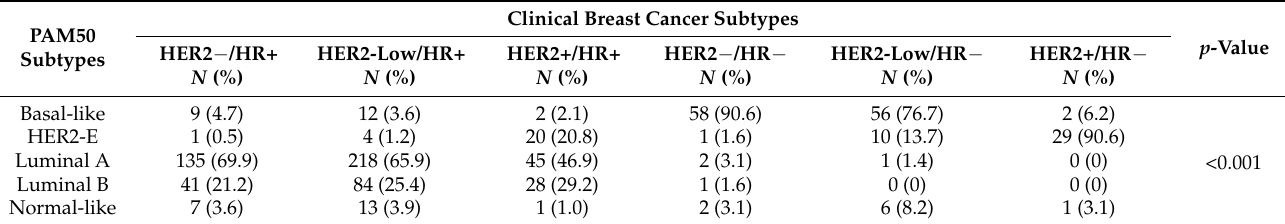
Figure 1. The distribution of PAM50 intrinsic subtypes in the entire cohort and among each breast cancer subtype ( n = 789). Abbreviations: HR: hormone receptor, HER2-E: HER2-enriched, LumA: Luminal A, LumB: Luminal B. Table 2. Distribution of PAM50 subtypes according to clinical subgroups.